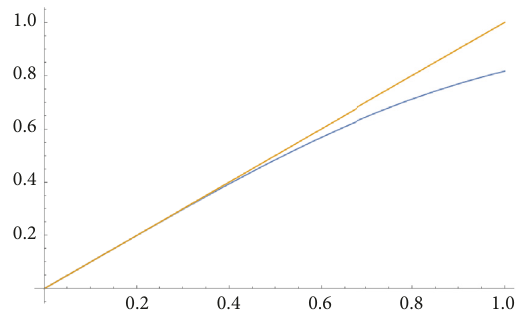
Figure 1: The plot of 𝐼(𝑎) for 𝑎 ∈ [0,10] . Figure 2: Approximation of 𝐼(𝑎) for 𝑎 ∈ [0,1] using Taylor expansion.